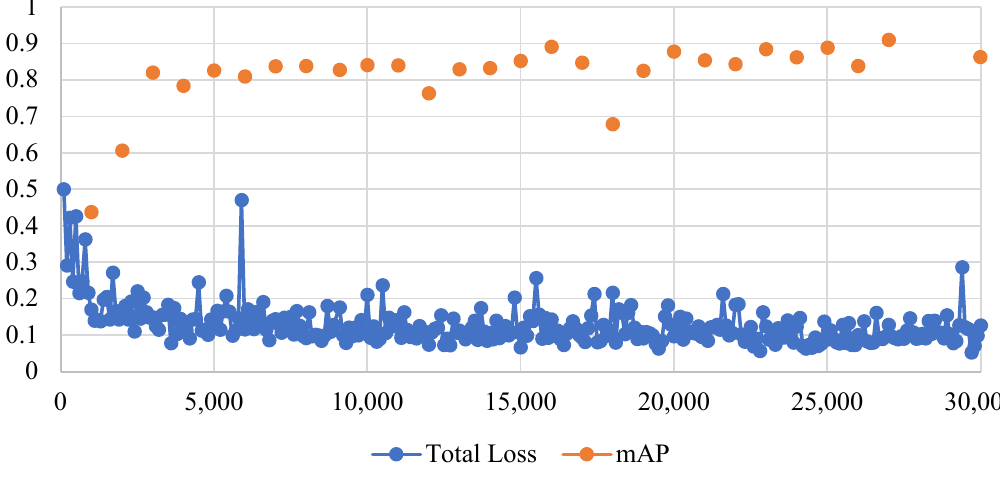
Figure 15. Training progress of EfficientDet during 30,000 steps and the mAP@0.50.